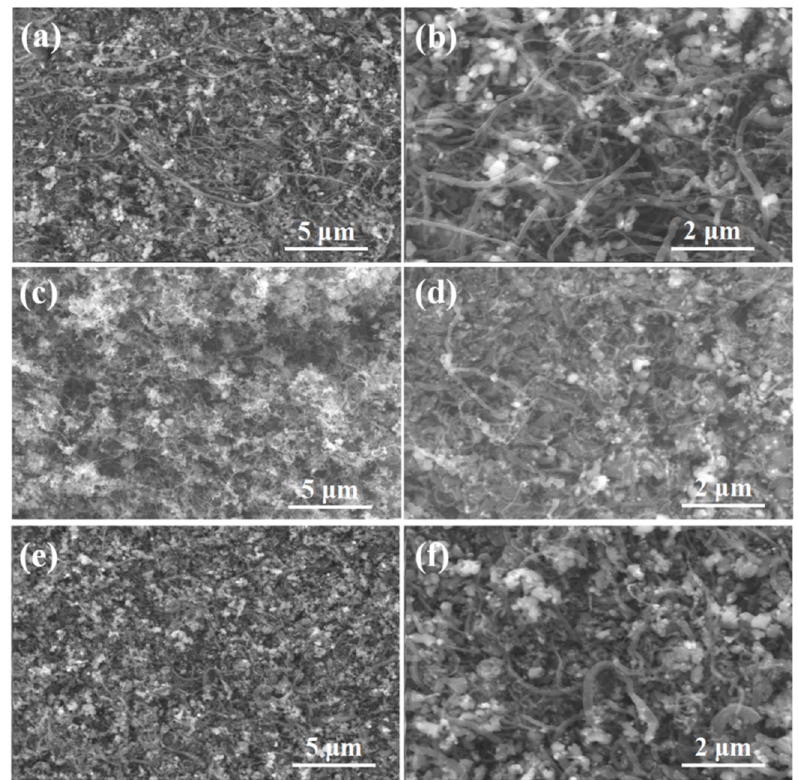
Figure 7. SEM images of CNCs synthesized with Ni/ α –Al 2 O 3 ( a , b ), NiCo/ α –Al 2 O 3 ( c , d ), and Co/ α –Al 2 O 3 ( e , f ) at 900 °C.